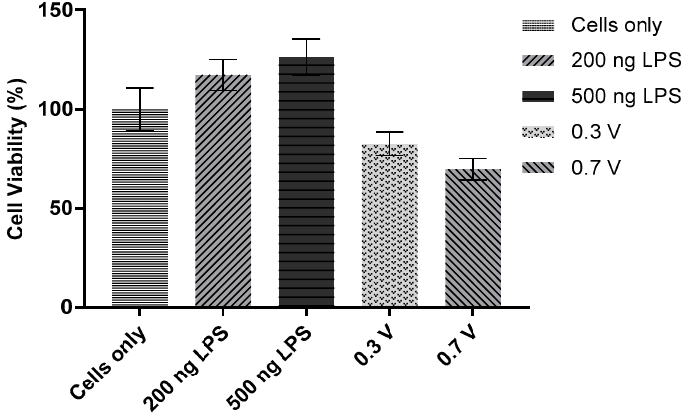
Figure 11. Effect of LPS or ROS probe operation on viability of RAW 264.7 cells. 96-well plates were seeded with 1 × 10 4 RAW 264.7 cells, grown to 50% confluency, and doped with 200 ng/mL or 500 ng/mL LPS, or probed at one of two potential steps: +0.7 V and +0.3 V. One-way ANOVA ( n = 6, p = 0.0029) and Tukey–Kramer post hoc analysis ( n = 6) were